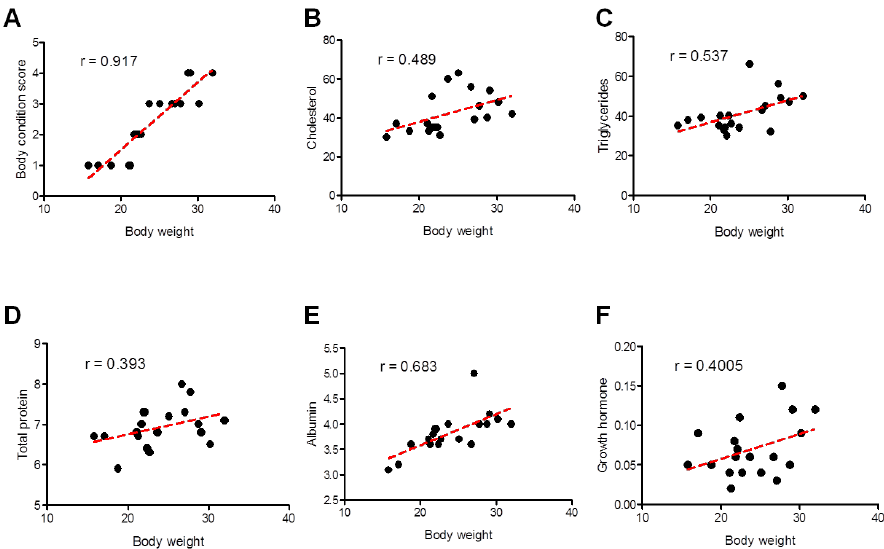
Figure 6. Correlation between different clinical and biochemical parameters against the body weight of all examined sheep. Scatter graphs show the correlation between body weight and different parameters including body condition score ( A ), cholesterol ( B ), triglycerides ( C ), total proteins ( D ), albumin ( E ), and growth hormone ( F ) from stunted ( n = 10) and good body condition sheep ( n = 9). The equation represents the approximation formula. The break line represents the calculated line of best fit. Correlation coeffi cients were calculated using Pearson’s correlation coefficient: |r| = 0.70 strong correlation; 0.5 < |r| < 0.7 moderately strong correlation; and |r| = 0.3 – 0.5 weak-to-moderate correlation. Additionally, we estimated the possibility of growth retardation in the studied ani- mals because of debilitating infections. We tested for internal parasites using a direct fecal smear and a concentration sedimentation/flotation technique. Different kinds of ELISAs were used to reveal debilitating protozoan ( T. gondii and N. caninum ) or bacterial ( Brucella spp., and C. burnetii ) infections that are endemic in our locality. There was no evidence of infection of tested pathogens, except for T. gondii , in which only one and two cases were identified as seropositive in test and control groups, respectively (Table 3) (Figure 7). Table 3. Serological testing of Barki sheep in good and poor condition.